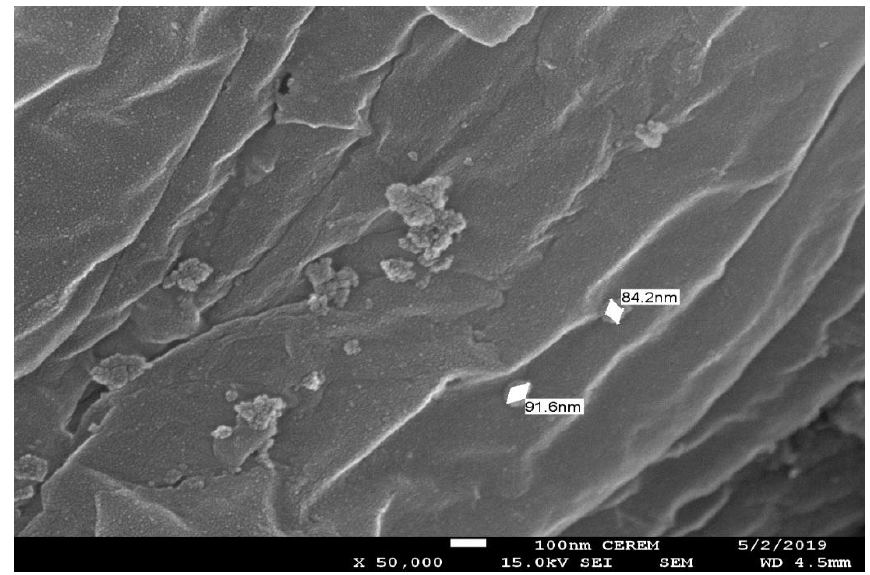
Figure 1. SEM of the nano-activated carbon prepared with 50000× magnification. Table 1. Chemical composition of Saudi red clay